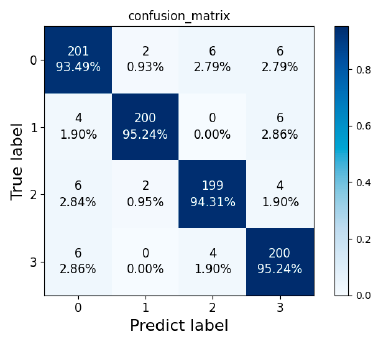
Figure 15. Lian-VGG classification model.